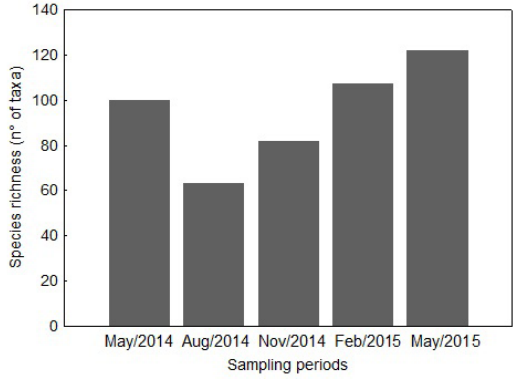
Figure 5. Temporal variation in total species richness during the sampling periods. May (May/2014) (Feb/2015) and May (May/2015).